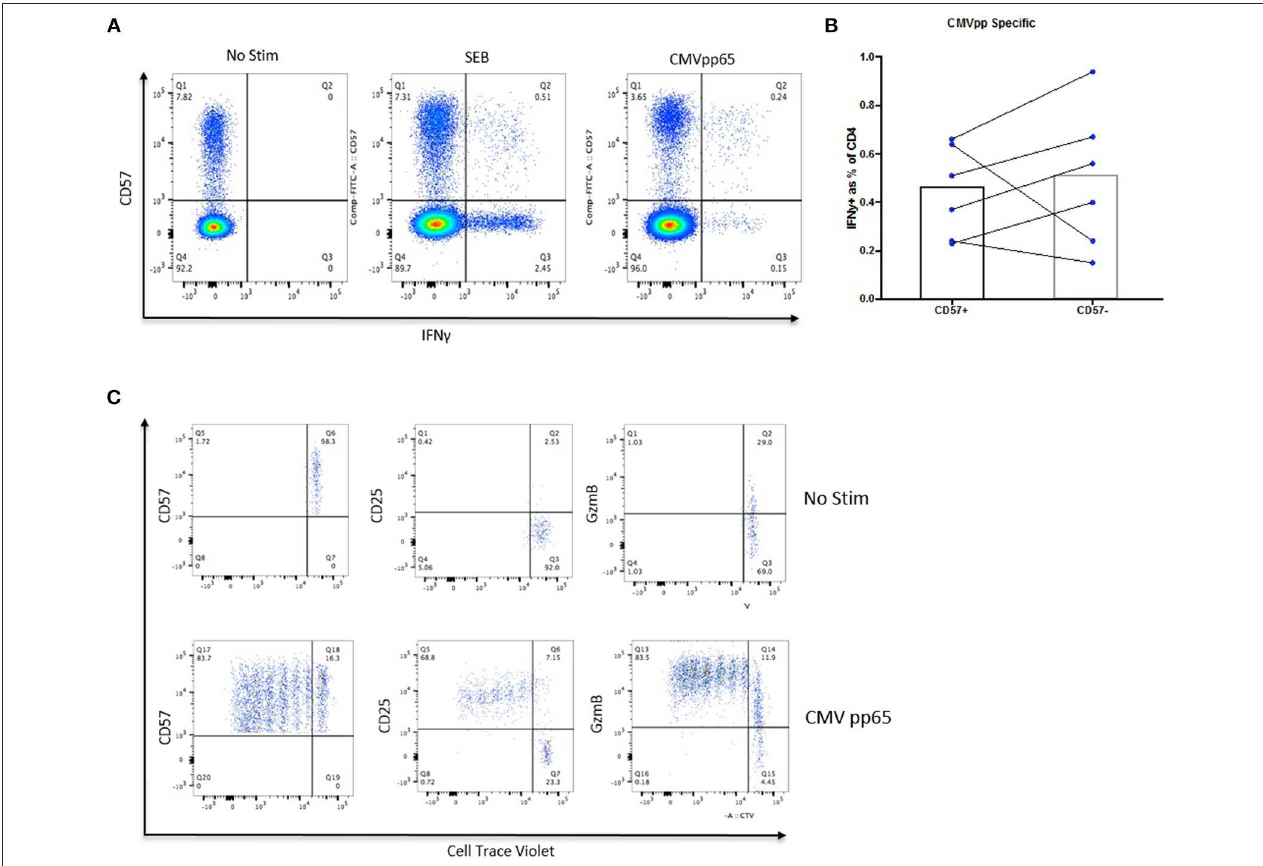
FIGURE 2 | CD57 + CD4 CTLs can proliferate and are antigen-specific. (A) IFN γ expression in SEB- and CMV-specific CD57 + CTLs. (B) No difference between IFN γ expression between CMV-specific CD57 + and CD57 − susbets. (C) Proliferation of CMV-specific CD57 + from healthy